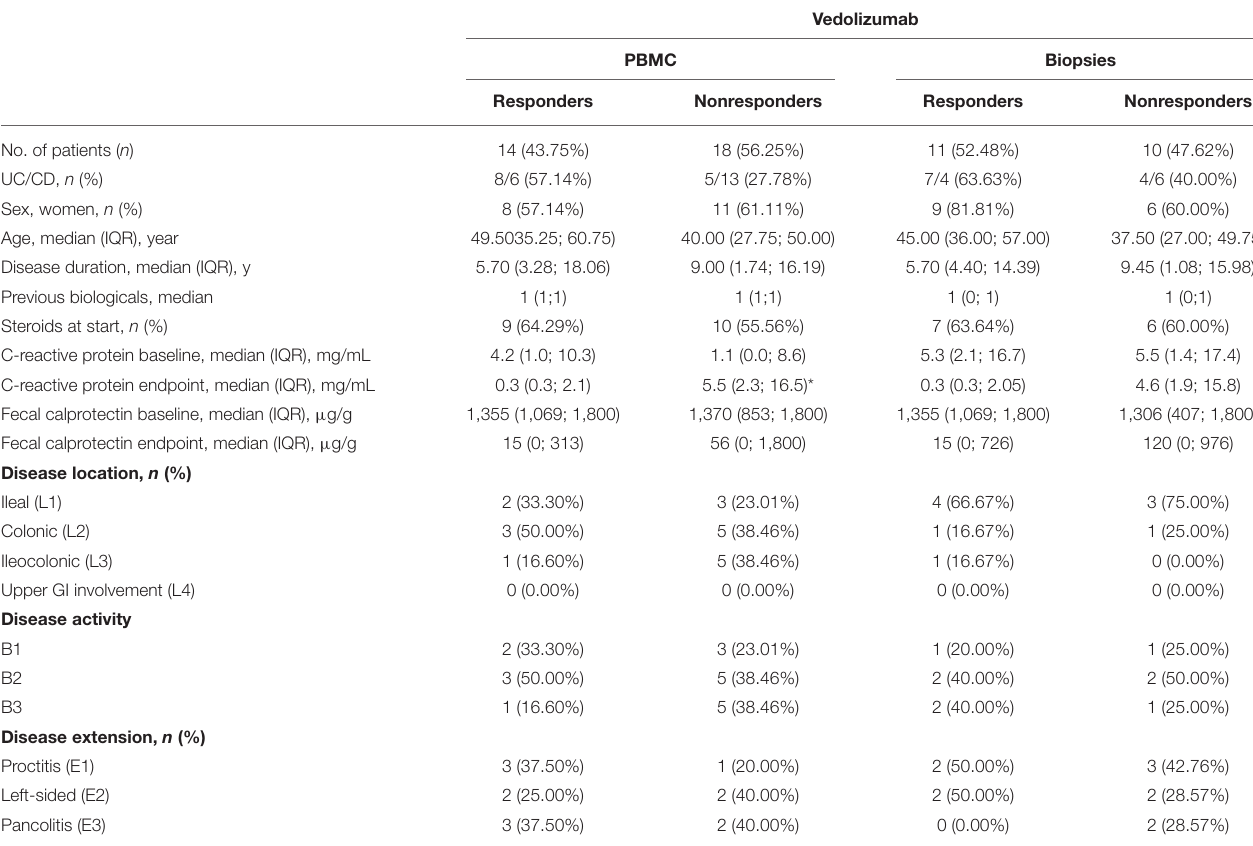
TABLE 4 | Demographic characteristics of patients on vedolizumab